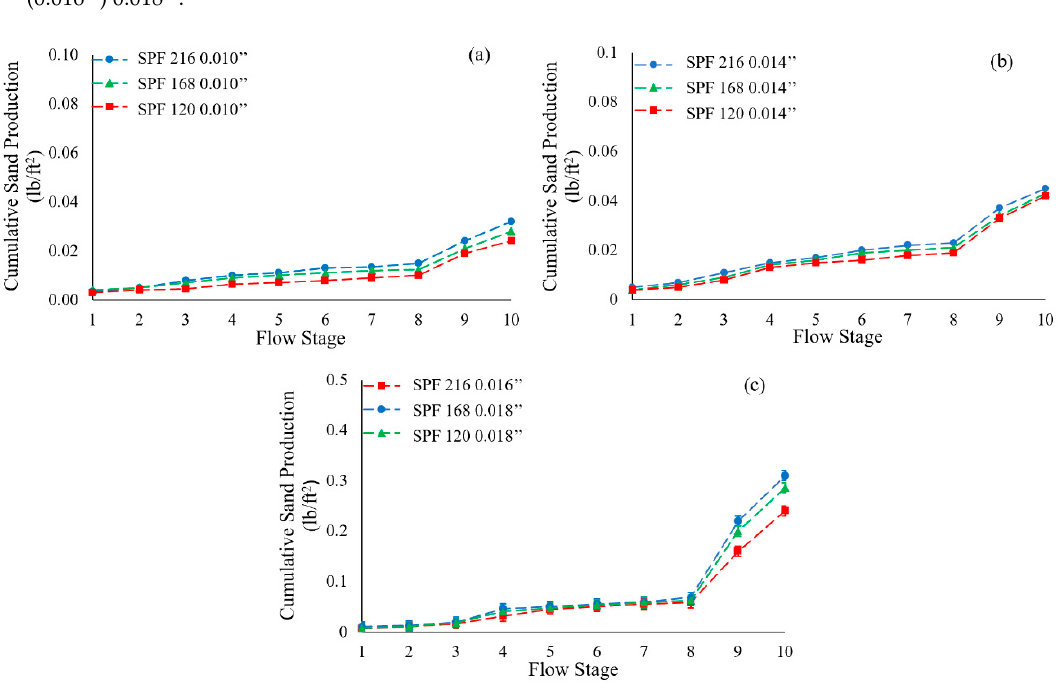
Figure 9. Produced sand results for DC-II using slot apertures of ( a ) 0.010 (cid:48)(cid:48) , ( b ) 0.014 (cid:48)(cid:48) , and ( c ) Figure 9. Produced sand results for DC ‐ II using slot apertures of ( a ) 0.010 ′′ , ( b ) 0.014 ′′ , and ( c ) (0.016 ′′ ) Figure 9. Produced sand results for DC ‐ II using slot apertures of ( a ) 0.010 ′′ , ( b ) 0.014 ′′ , and ( c ) (0.016 ′′ ) (0.016 (cid:48)(cid:48) ) 0.018 (cid:48)(cid:48) 0.018 ′′ . 0.018 ′′ .